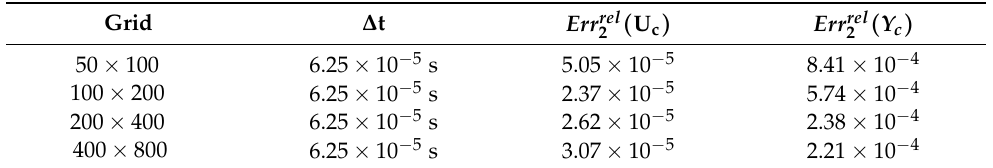
Table 2. Free fall of a dense cylindre—Values of Err rel with Fully-coupled (FC) method, throughout the simulation, after 0.144 s.